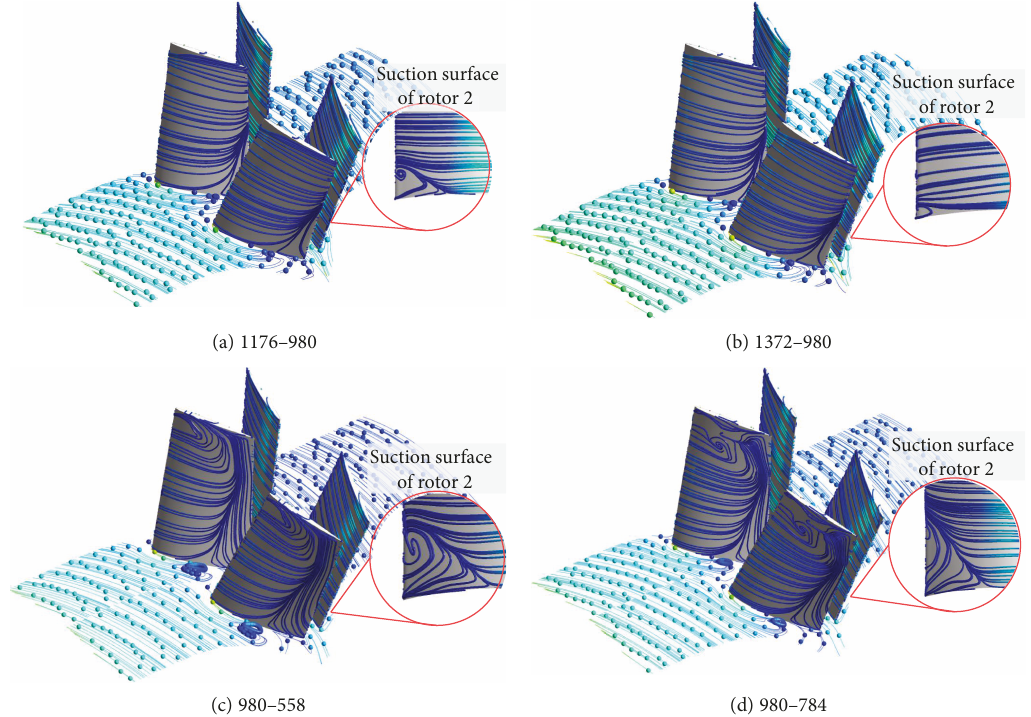
Figure 12: Streamline diagram of CRF with rotating speed variation under small fl ow